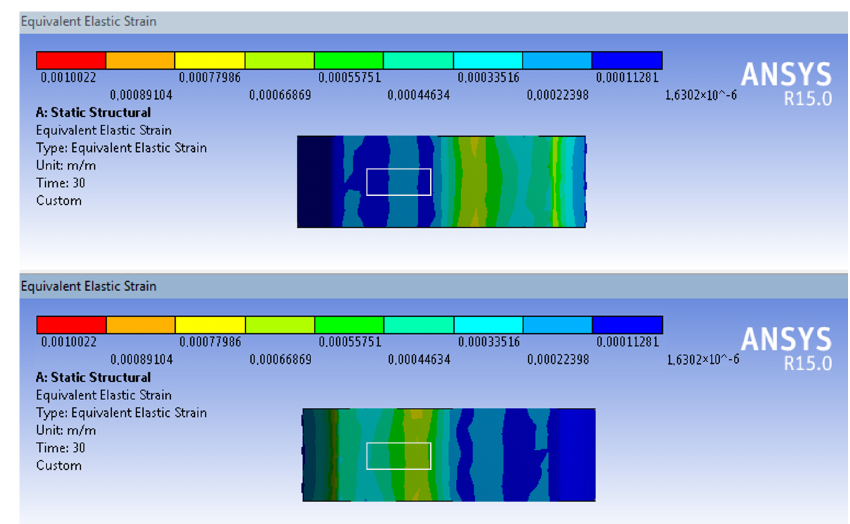
Figure 8. Simulated strain with counter-clockwise applied torque at maximum value (60 Nm) where the white outlined box indicates the strain-gauge placement location: ( top ) upper surfaces; ( bottom ) lower surface.